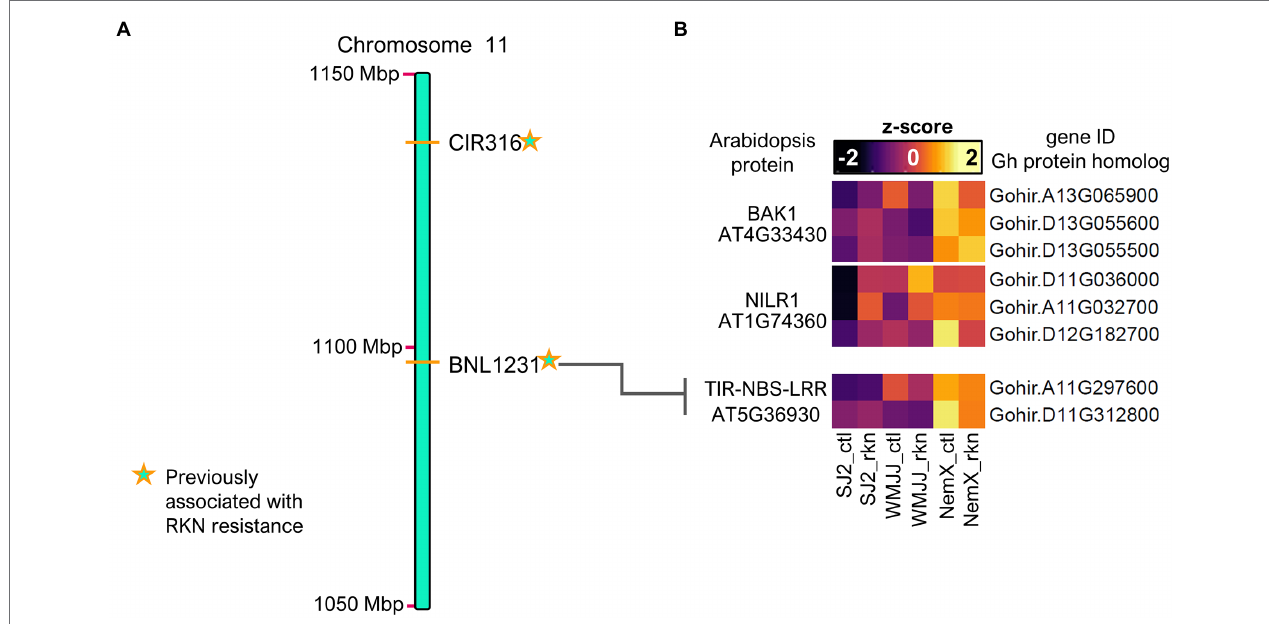
FIGURE 7 | Basal expression of genes coding for PAMP-receptors and Resistance proteins is enhanced in NemX with respect to WMJJ and SJ2. (A) Section of linkage map illustrating microsatellite markers previously associated with RKN-resistance (Wang et al., 2020) present in Gh chromosome 11. (B) Heatmap of expression values of Gh genes coding for orthologs of (top) BAK1 a co-receptor for PAMPs, (middle) NILR1 a kinase required for innate immunity to nematodes in Arabidopsis and (bottom) a TIR-NBS-LRR R protein possibly implicated in nematode resistance in